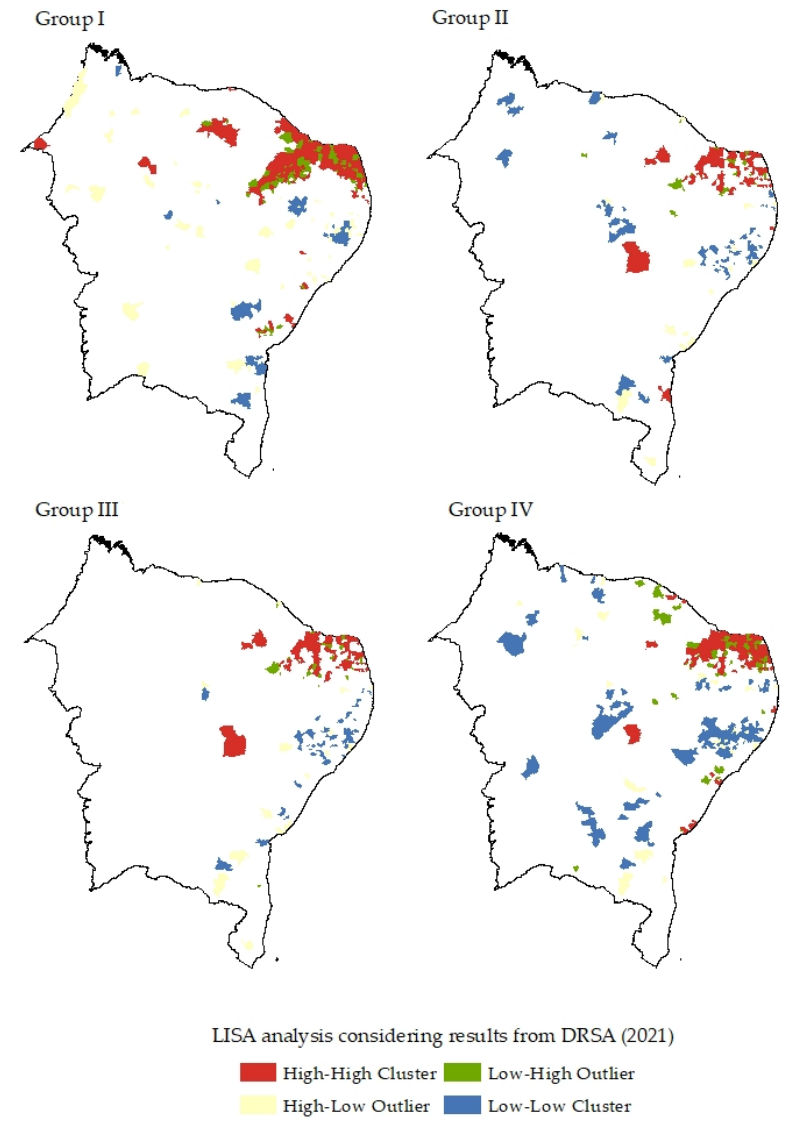
Figure 7. LISA analysis after DRSA results of COVID-19 cases registered in 2021. Each group describes the clusters obtained from the Moran index applied to the year of 2021.